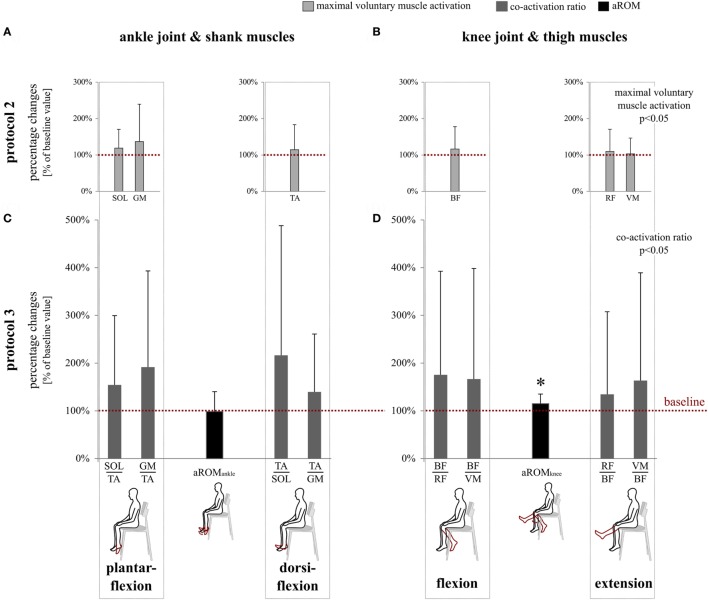
This graph illustrates percent changes in neuromuscular and kinematic parameters. The red dotted lines serve as references and mark baseline values at 100% referring to data collected before whole-body vibration (WBV). (A) Modulations of maximal voluntary muscle activation for the antagonist muscles encompassing the ankle joint [m. soleus (SOL), m. gastrocnemius medialis (GM), and m. tibialis anterior (TA)] and (B) knee joint [m. biceps femoris (BF), m. rectus femoris (RF), and m. vastus medialis (VM)] for joint flexion and extension. The rmANOVA revealed a significant increase (p < 0.05) in response to WBV. (C) WBV-induced modulations in co-activation ratios of the muscles surrounding the ankle joint and (D) knee joint and corresponding active ranges of motion (aROM). The rmANOVA revealed a significant increase in co-activation ratios (p < 0.05) and knee joint excursion (p < 0.05) in response to WBV. Data are normalized to control values obtained prior to WBV. Significant changes in aROM are illustrated by *p < 0.05.